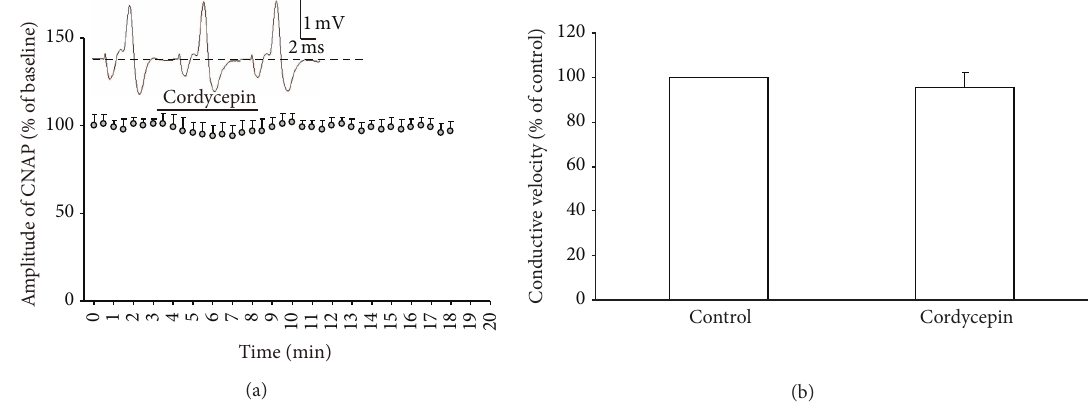
Figure 3: Effects of 50 mg/L cordycepin on amplitude and conductive velocity of compound nerve action potential (CNAP) in Ca 2+ -free medium. (a) Sample traces (top) show the CNAP recorded before, during, and after cordycepin was applied. Below are the time courses of the effects of cordycepin on the amplitude of CNAP conduction. Horizontal bar indicates the bath application of cordycepin. (b) Summary of changes in conductive velocity of CNAP induced by cordycepin. The velocity of the stable state before the nerve was exposed to cordycepin is defined as the control value and scaled to